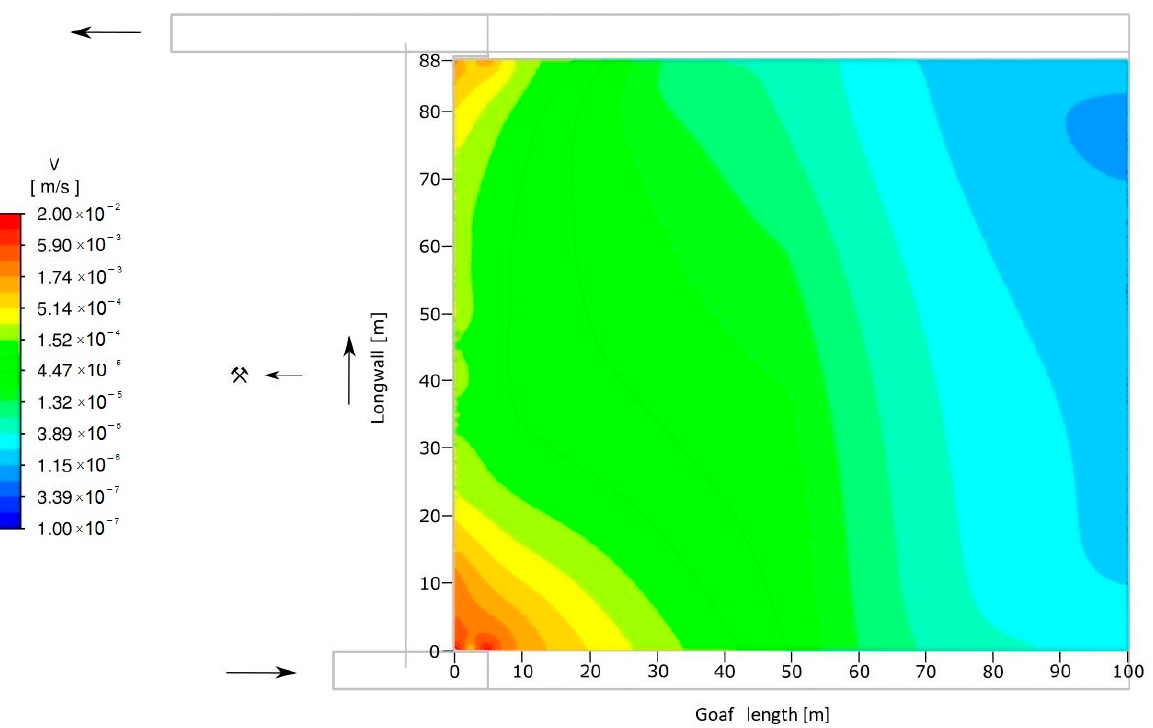
Figure 9. Velocity contours on a logarithmic scale in the range from 1.0 × 10 − 7 m/s to 0.02 m/s for a model with constant parameters of porosity and permeability in the goaf. During the analysis of the presented velocity contours, changes in the air flow distri- bution velocity behind 50 m of the goaf length should be noticed. In the model with vari- able porosity and permeability parameters, the air flow decreased much faster compared to the model with constant parameters for entire area of the goaf. The lowest observed velocities in the model with variable parameters should be observed at 100 m of goaf length along the entire longwall length, reaching a value of 3.4·× 10 − 7 m/s (Figure 8). In the case of a model with constant parameters, the smallest velocities are also located at 100 m of goaf length. Not over the entire longwall length, but between 0–10 m and 60–88 m of a longwall, the air flow velocities reach 4.0·× 10 − 6 m/s (Figure 9). The analysis of the velocity contours in the vicinity of the longwall fall line showed slight differences in the air flow velocity between the two models.